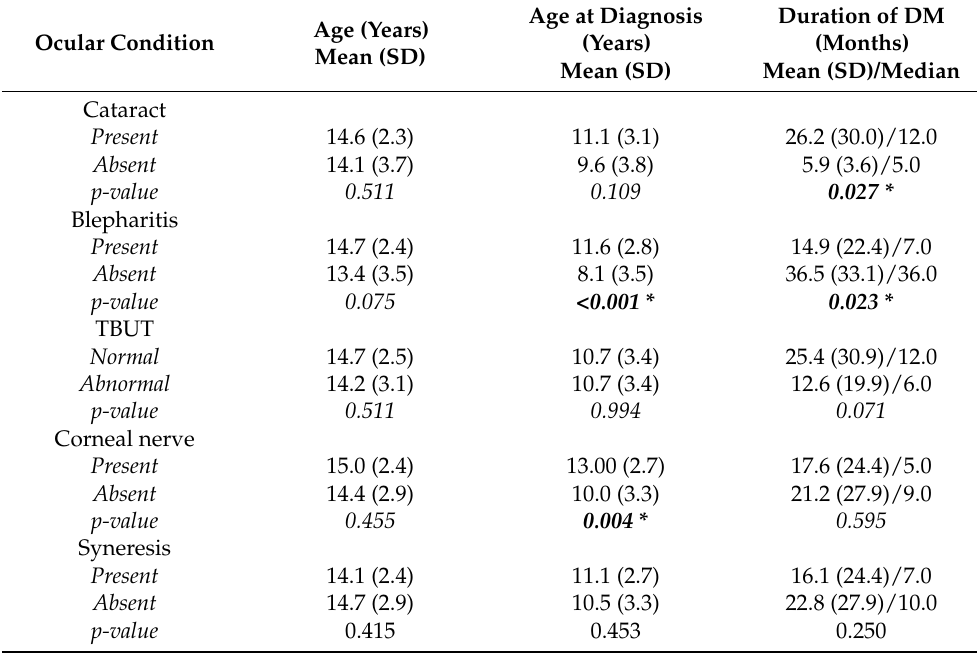
Table 3. Distribution of subjects according to associations between various ocular findings and current age, age at diagnosis, and duration of diabetes in children and adolescents with diabetes mellitus.